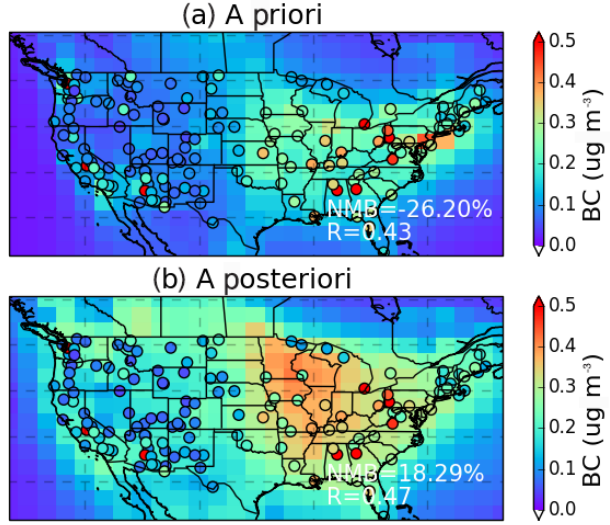
Figure 13. Evaluation a priori (a) and a posteriori (b) GEOS-Chem simulated annual mean surface BC concentration in the Unite States with observations (circles) from the IMPROVE network for the year 2010. The correlation coefficient ( R ) and normalized mean bias (NMB) are provided in the bottom right